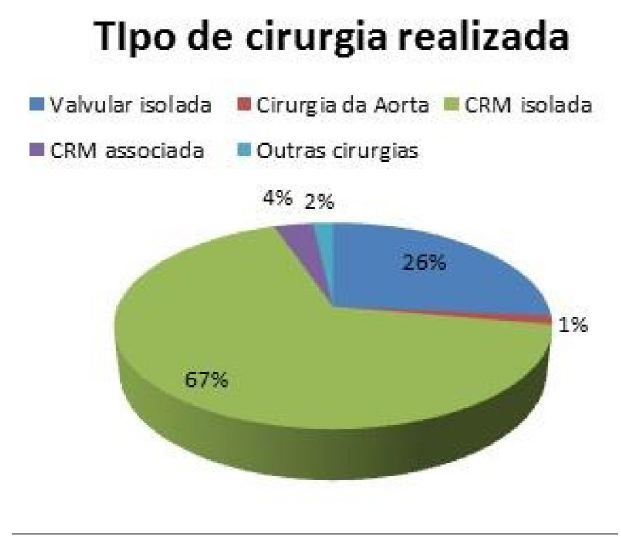
Fig.1 – Characteristics of the sample according to the surgery performed